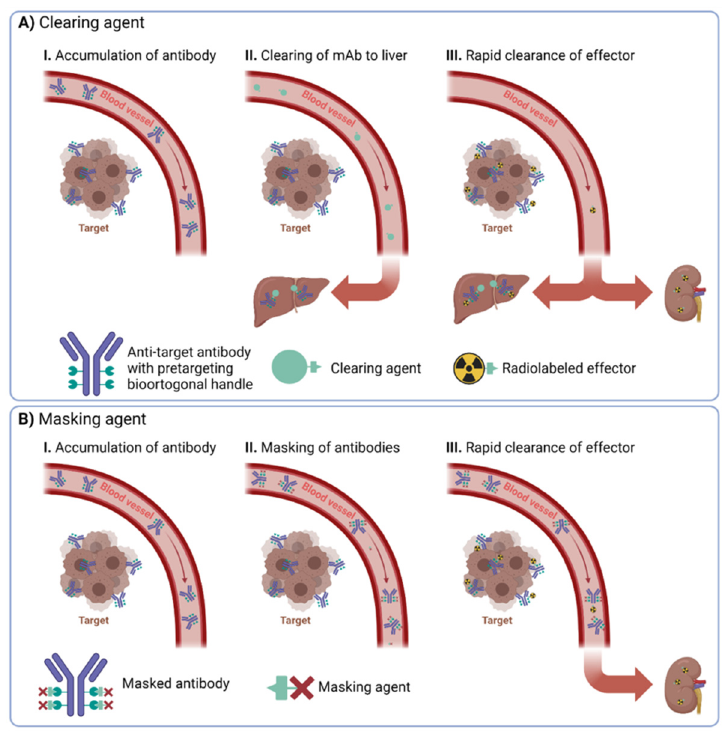
Figure 1. Overview of the difference between ( A ) clearing and ( B ) masking agents.